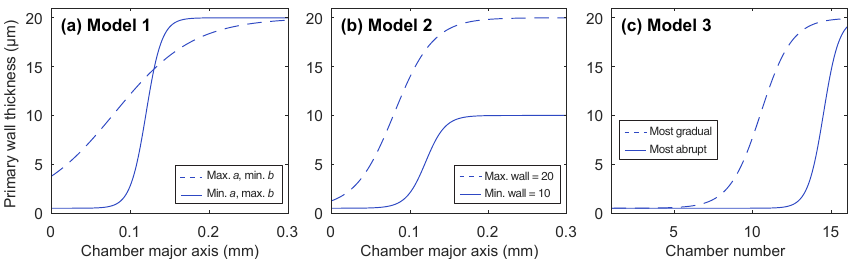
Figure A1. Scaling of wall thickness with chamber size in the calcification models, showing the principal difference between the models described in Sect. 2.4.2. (a) Model 1 was designed to test the effect of varying the slope (parameterised by constants a and b ) of this relationship. (b) Model 2 was designed to test the effect of varying the maximum primary chamber wall thickness, while keeping a and b roughly constant. (c) Model 3 parameterises wall thickness as a function of chamber number instead of body size. The two lines in each model show the maximum extent by which this regression was allowed to randomly vary, and therefore delineate model extremes. See Eq. (A2) for the definition of this